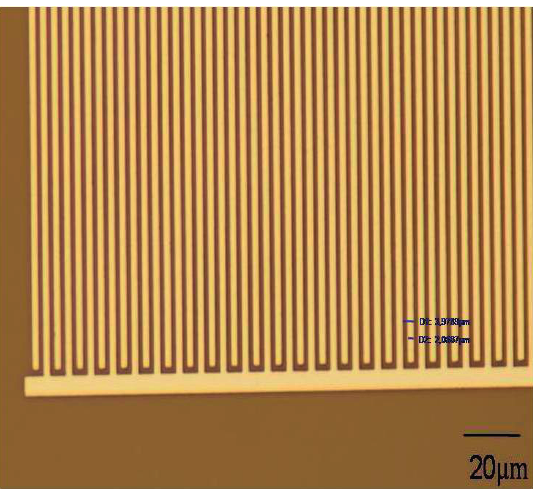
Figure 2. Optical micrograph of the IDE